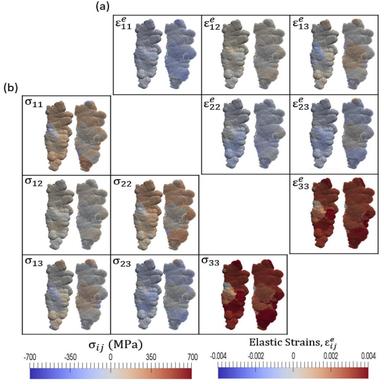
(a) Grain average elastic strain tensor for each grain adjacent to the crack on the front and the back face, measured through FF-HEDM, at 20,000 cycles. (b) Grain average stress tensor calculated for each grain adjacent to the crack (see (d) for crack view perspective).